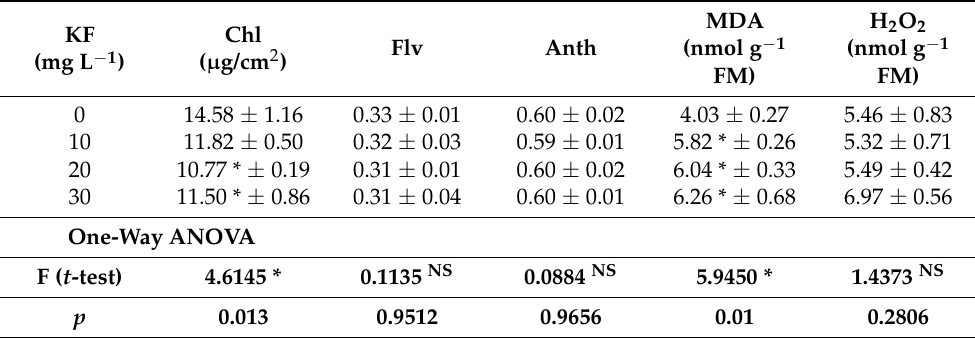
Table 3. Chlorophyll content (Chl), epidermal flavanol content (Flv), anthocyanin index (Anth), malonaldehyde (MDA), and hydrogen peroxide (H 2 O 2 ) in Lactuca sativa L. leaves after 40 days of